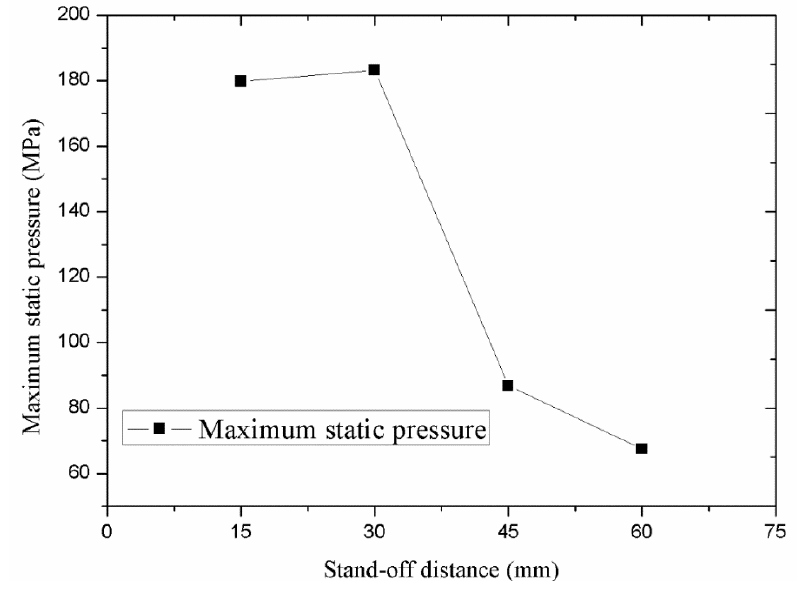
Figure 17. Influence of stand-off distance of nozzle on the static pressure on the impacting surface.